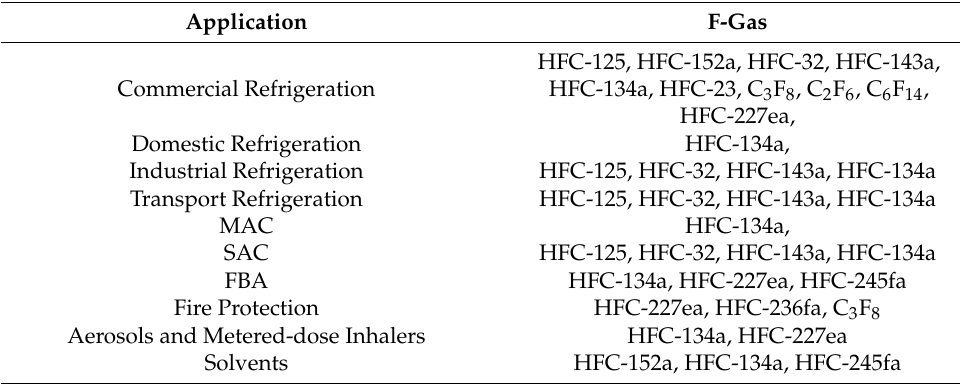
Table 1. List of F-gases and their applications in the Czech Republic.